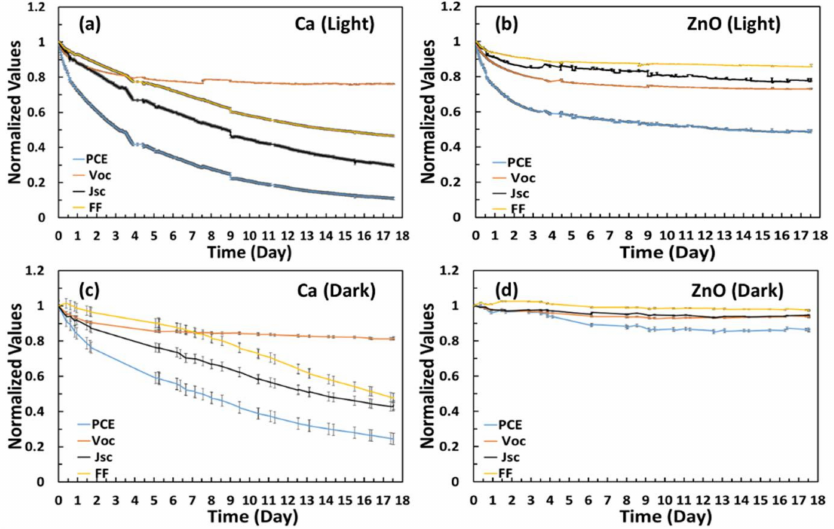
Figure 3. ( a ) Temporal stability of device parameters of power conversion efficiency (PCE), open circuit voltage (V OC ), short circuit current density (J SC ), and device fill factor (FF) as a function of light exposure time for both Ca ETL under light ISOS–L 2 and ( c ) dark ISOS–D 2 degradation conditions, ( b ) for ZnO ETL under light ( d )